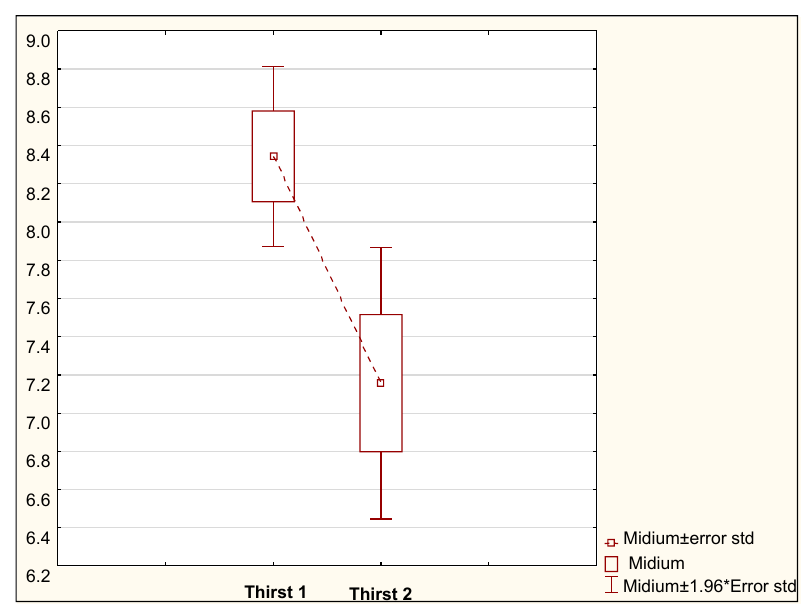
Figure 2. Comparison of average thirst levels before and after administration of an ice cube.